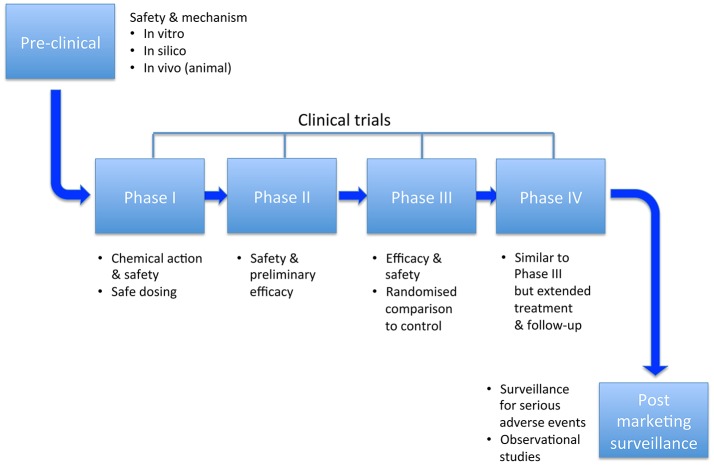
Milestones of research and development.